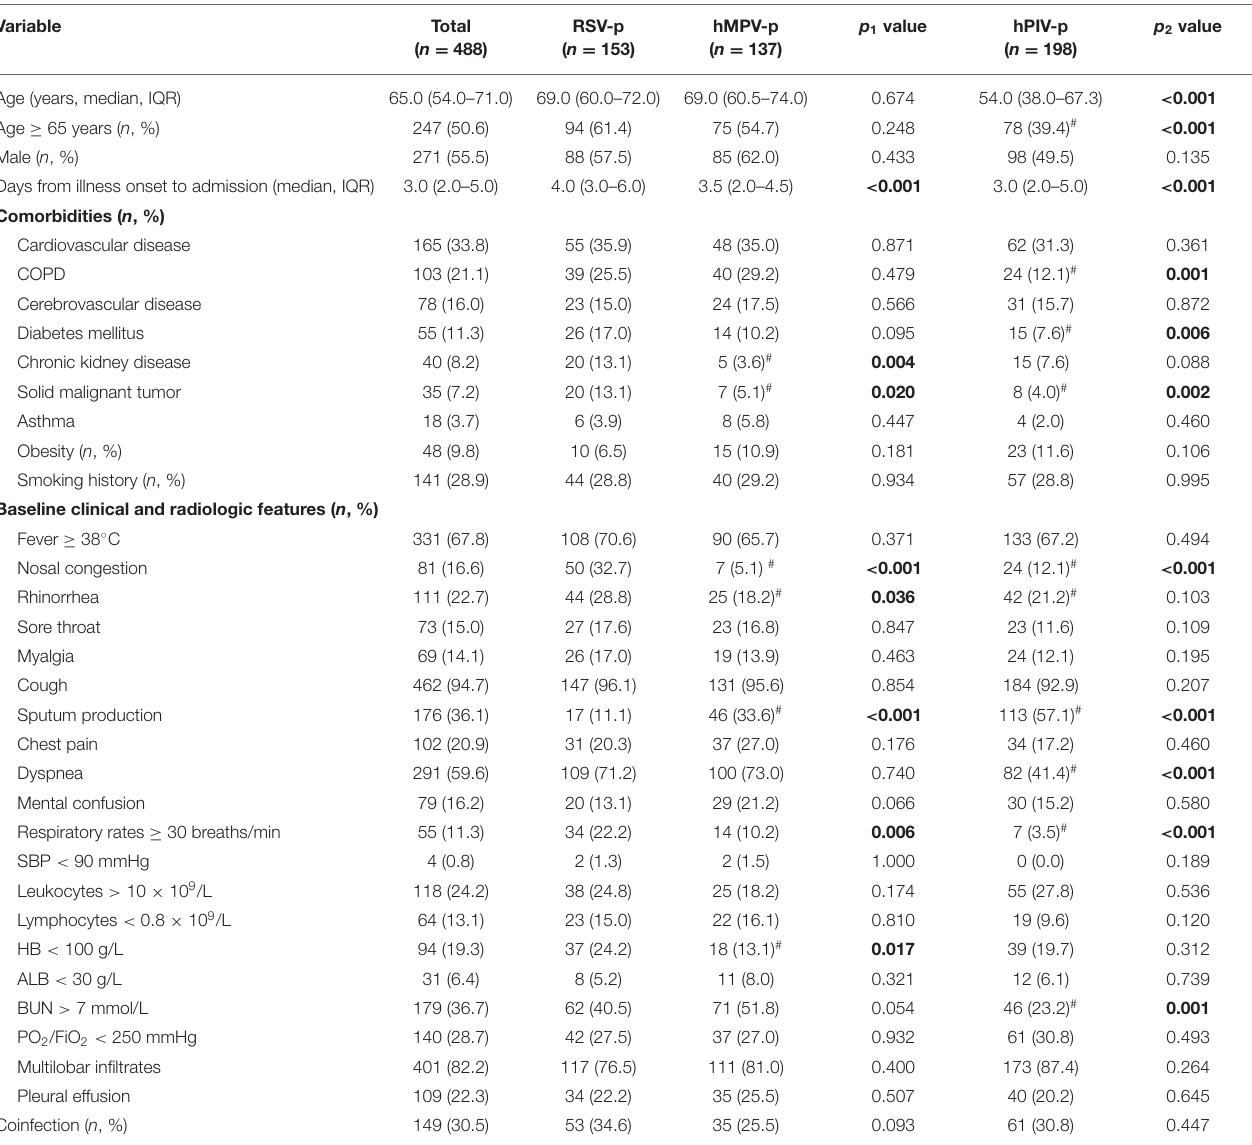
TABLE 1 | Demographic and clinical features of patients with the three types of PMVs-p.